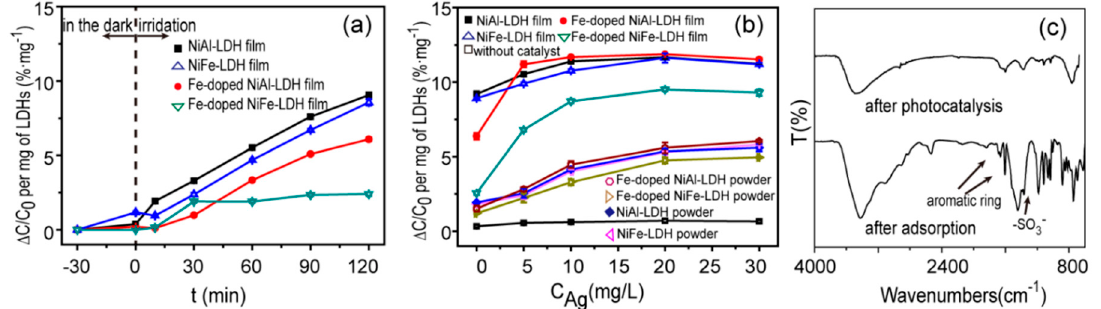
Figure 5. ( a ) Photocatalytic activity of methyl orange for LDH films without Ag ions. ( b ) Effect of Ag ion concentration on degradation of methyl orange under 120 min illumination. C 0 : the equilibrium concentration of methyl orange before irradiation, ∆ C: the change in the concentration of methyl orange after irradiation. ( c ) FTIR spectra of NiAl–LDH films after photocatalytic experiments and adsorption experiments.